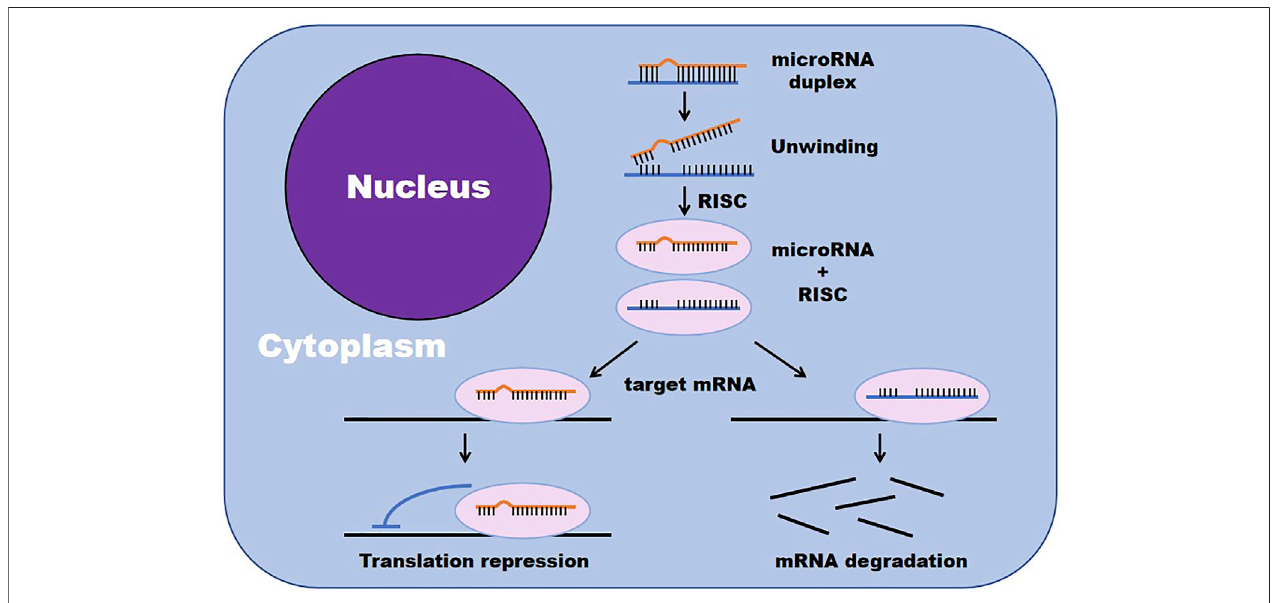
FIGURE 2 | miRNAs negatively regulate gene expression by affecting the translation of target mRNAs. (RISC, RNA-induced silencing complex).